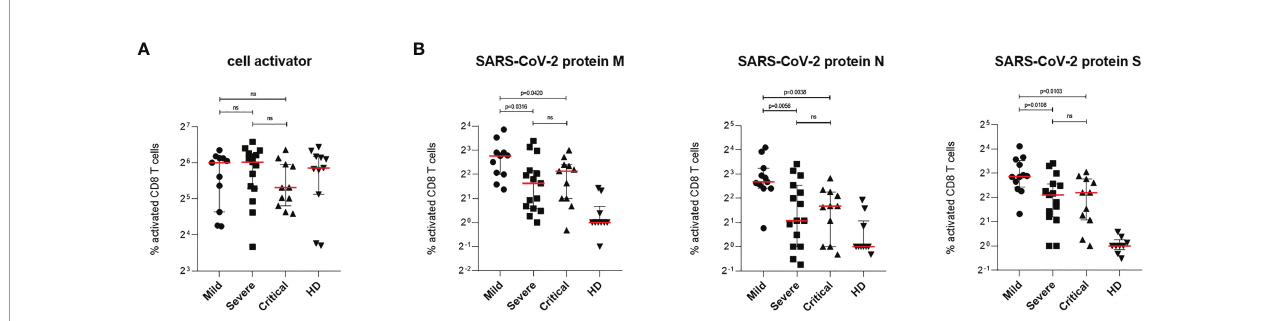
FIGURE 2 | SARS-CoV-2-speci fi c CD8 + T cells response in patients with mild, severe or critical COVID-19. PBMCs from COVID-19 patients and HD were stimulated 6 h at 37°C using either cell activator cocktail or SARS-CoV-2 PepTivator ® peptide pools. Cells were fi xed after extracellular staining for CD8 + expression and then permeabilized. Intracellular staining was performed to determine polyfunctionality of T cells by measuring IL-2, IFN- g , TNF- a and MIP-1 b levels. Cells were analyzed by fl ow cytometry and activation was assessed by comparison of cytokine production with unstimulated cells. T cell activation was increased in all three COVID-19 groups compared to HD group. (A) Percentages of activated SARS-CoV-2-speci fi c CD8 + T cells upon stimulation with cell activator cocktail are shown for each donor and median values are represented as red lines. (B) Percentages of SARS-CoV-2-speci fi c CD8 + T cells upon stimulation with peptide pools covering the complete SARS-CoV-2 proteins M (left), N (middle) or S (right) are illustrated. Statistical variability is presented as interquartile range. Statistical differences were determined using the two-tailed unpaired student ’ s t-test. ns, not signi fi cant.